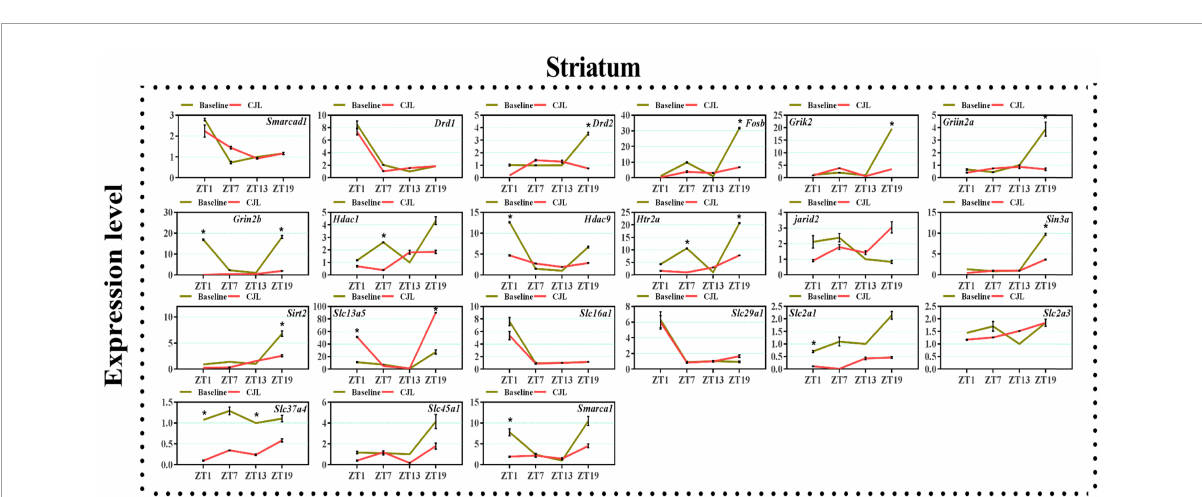
FIGURE6 Chronic jetlag (CJL) altered mRNA levels of genes associated with psychiatric disorders in the striatum. This figure shows mRNA levels in striatum extracts from baseline and CJL treated animals ( n = 3 per group), as assayed by three independent qPCR assays, at four different time points (ZT1, ZT7, ZT13, and ZT19). Results are expressed as mean ± SEM. * P < 0.01, two-way